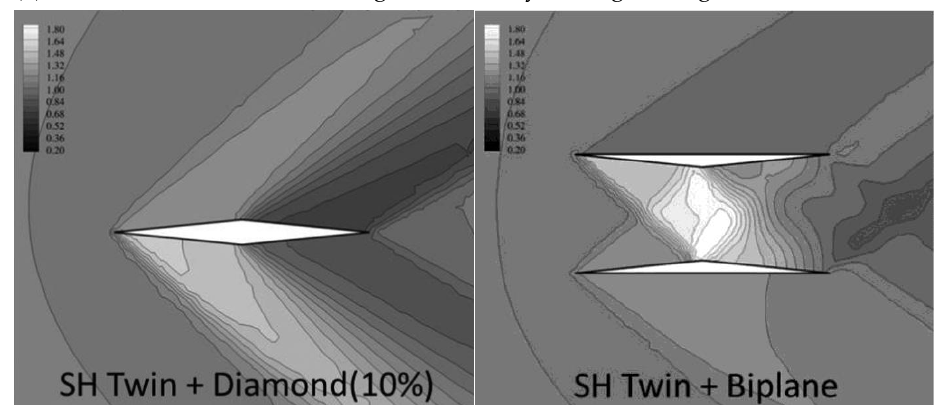
sults show that the lift and lift-to-drag ratios of the aircraft can be improved by using high- pressure capture wings, as shown in Figure 11.